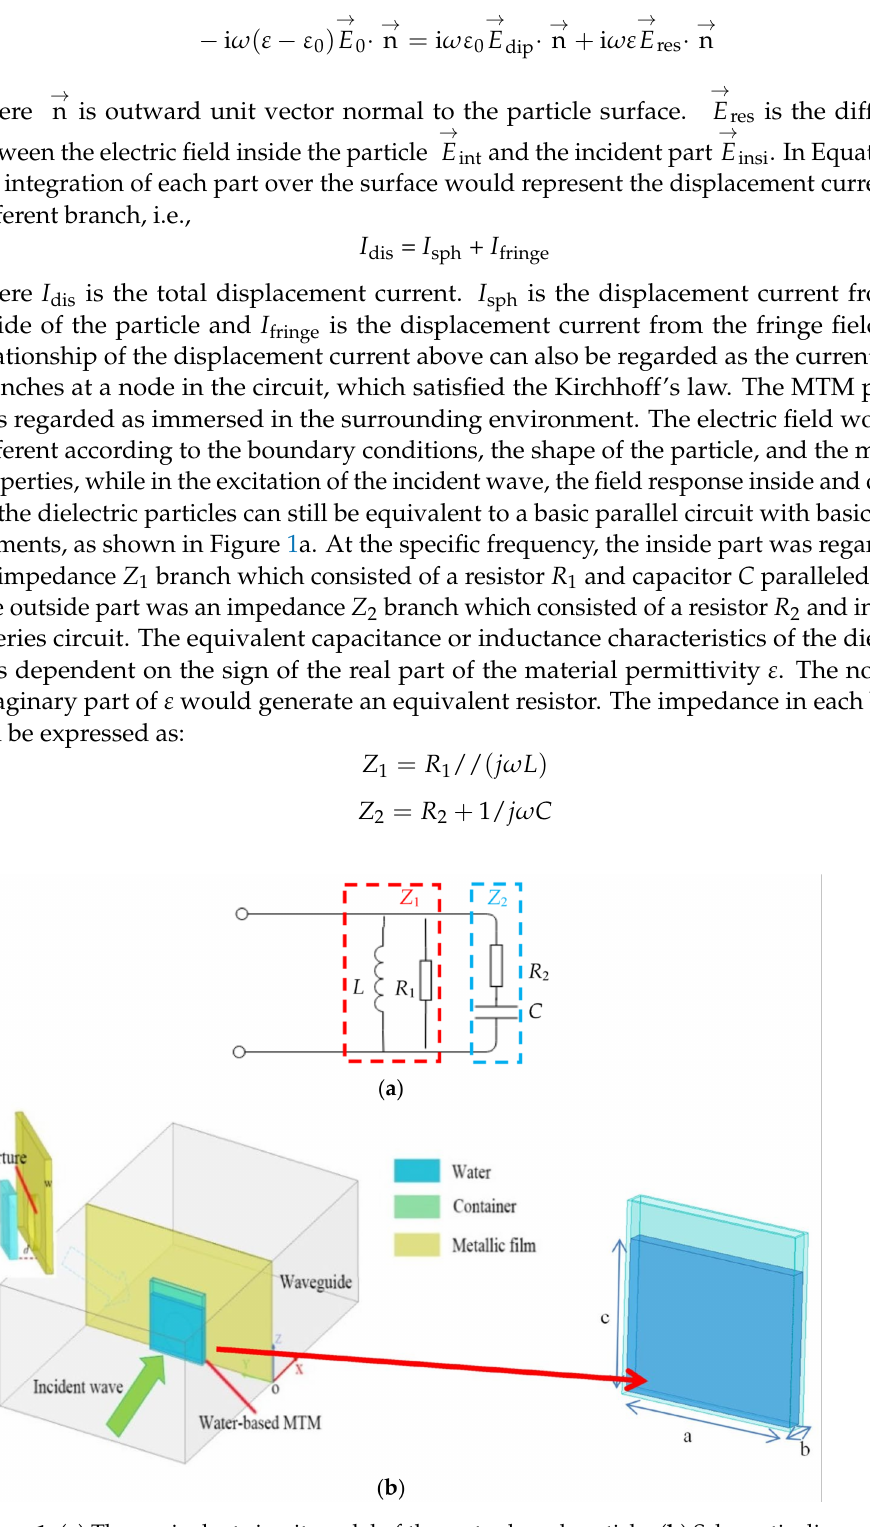
Figure 1. ( a ) The equivalent circuit model of the water-based particle. ( b ) Schematic diagram of the waveguide system and the water-based MTM